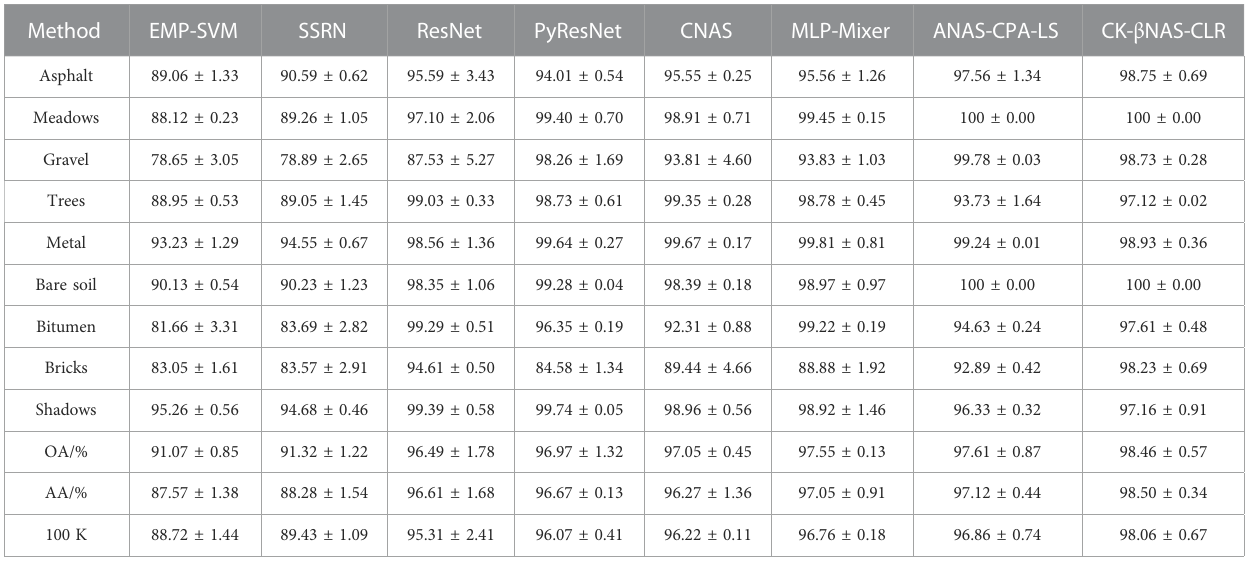
TABLE 2 Performance comparison of different methods of the Pavia University dataset.